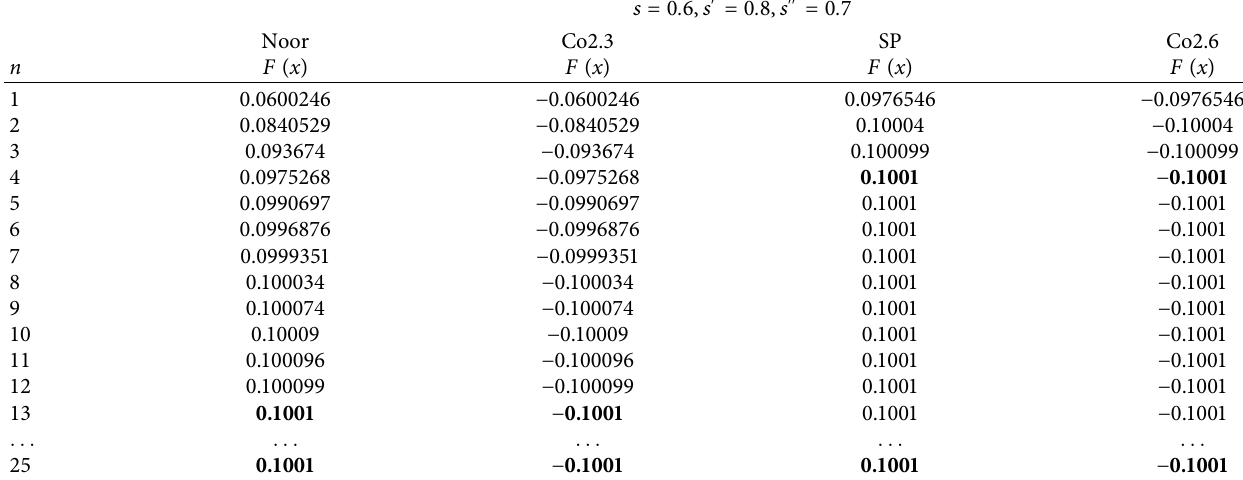
Table 8: Iterations of biquadratic function s � 0 . 6 ,s ′ � 0 . 8 ,s ″ � 0 .